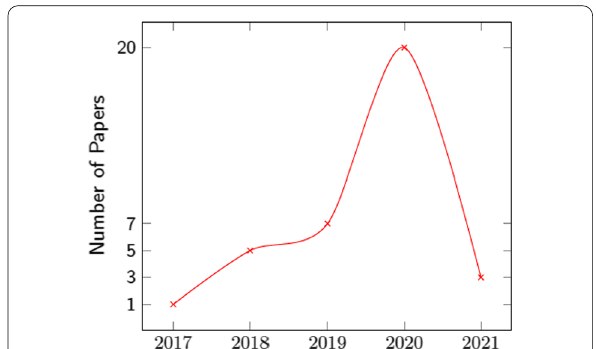
Fig. 3 The graph depicts the gradual increase of studies on data augmentation with synthetic MRI examinations to enhance cancer